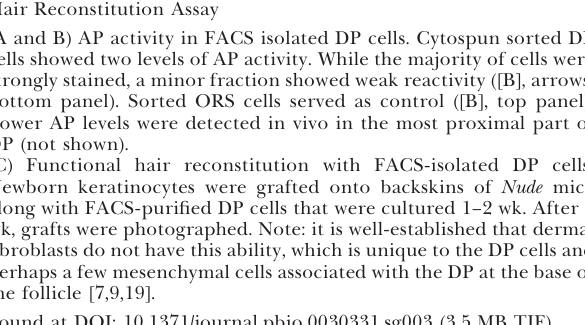
Figure S3. Variable AP Activity of Sorted DP Cells and Functional Hair Reconstitution Assay (A and B) AP activity in FACS isolated DP cells. Cytospun sorted DP cells showed two levels of AP activity. While the majority of cells were strongly stained, a minor fraction showed weak reactivity ([B], arrows, bottom panel). Sorted ORS cells served as control ([B], top panel). Lower AP levels were detected in vivo in the most proximal part of DP (not shown). (C) Functional hair reconstitution with FACS-isolated DP cells. Newborn keratinocytes were grafted onto backskins of Nude mice along with FACS-purified DP cells that were cultured 1–2 wk. After 3 wk, grafts were photographed. Note: it is well-established that dermal fibroblasts do not have this ability, which is unique to the DP cells and perhaps a few mesenchymal cells associated with the DP at the base of the follicle [7,9,19]. Figure S4. RT-PCR Confirmation of Molecular Backbone Genes Semi-quantitative RT-PCR of genes of the Molecular Backbone group of present and unchanged genes. Shown are representative examples of genes involved in RNA and protein metabolism. Figure S5. Real-Time PCR Confirmation of Signature Genes and Correlation with Microarray Results Real-time PCR confirmation of selected novel and control genes from Figures 2C and 5A. Note the consistent distribution of genes between cell populations using both PCR methods (top panels and Figures 2C and 5A). As a measure of the performance of the microarrays, average signal values were plotted for each gene along with the real- time PCR results (bottom panels). Note the near-perfect match at the quantitative level. Table S1. Correlation Coefficients of Array Hybridizations Raw data of correlation coefficients as shown in Figure 3A. The p - values of replicates are highlighted in bold. Found at DOI: 10.1371/journal.pbio.0030331.st001 (16 KB XLS). Table S2. Microarray Expression Reports